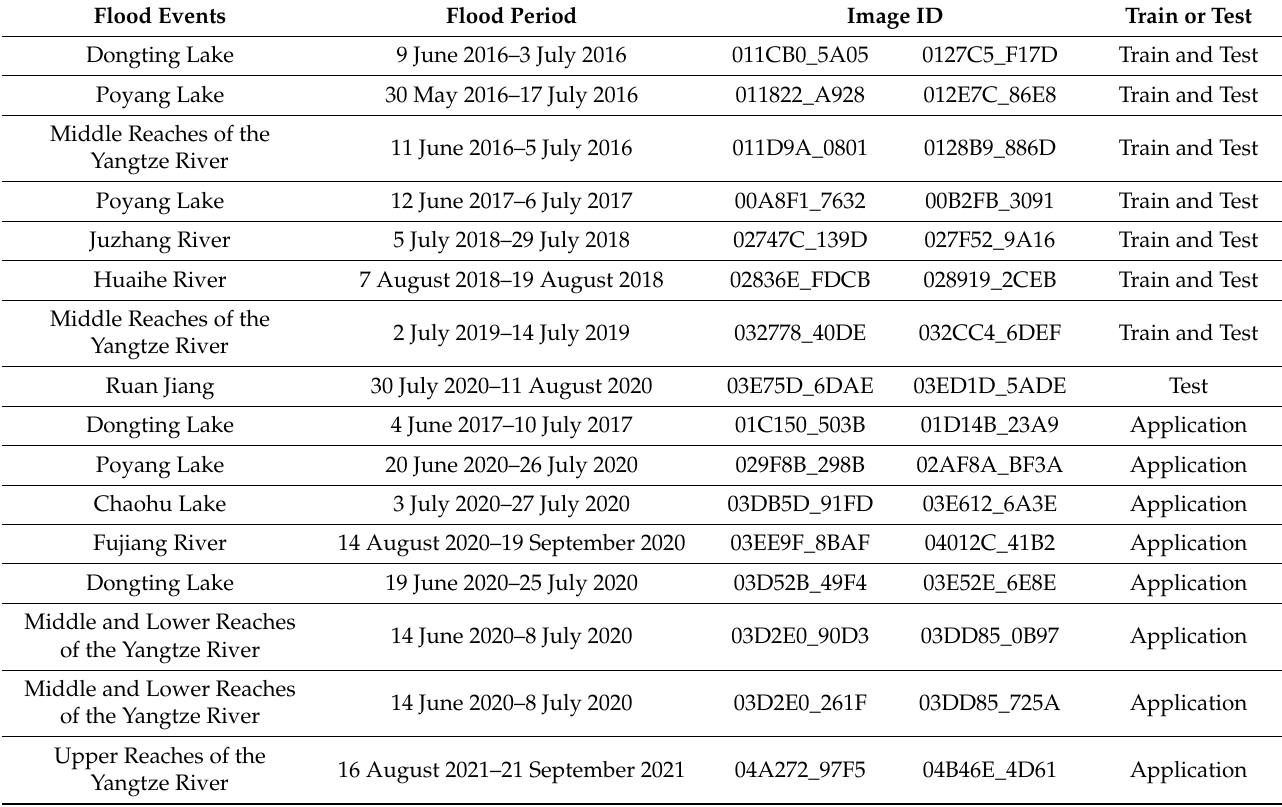
Table 1. Information about the selected flood events and the corresponding Sentinel-1 SAR images used in present